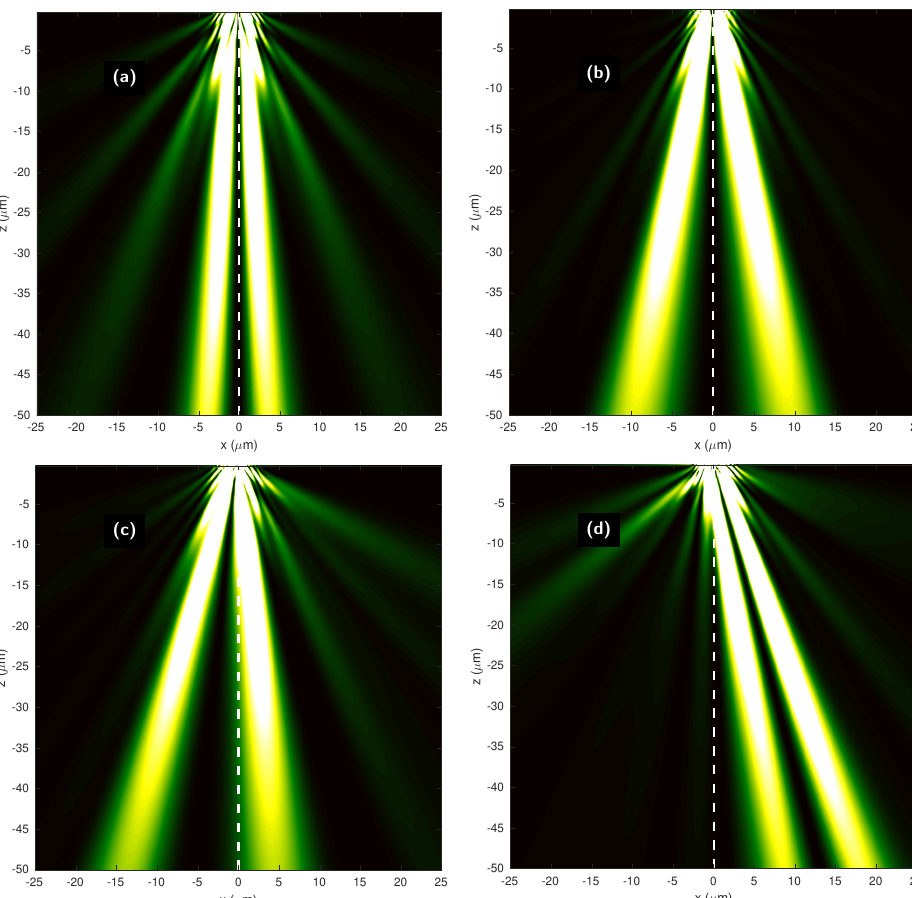
2 distributions for optimum dual-beaming cases. The H y | | 5 ◦ ,5 ◦ ) , ( b ) ( 10 ◦ ,10 ◦ ) , ( c ) ( 15 ◦ ,5 ◦ ) , and ( d ) ( 10 ◦ ,20 ◦ ) . − − −